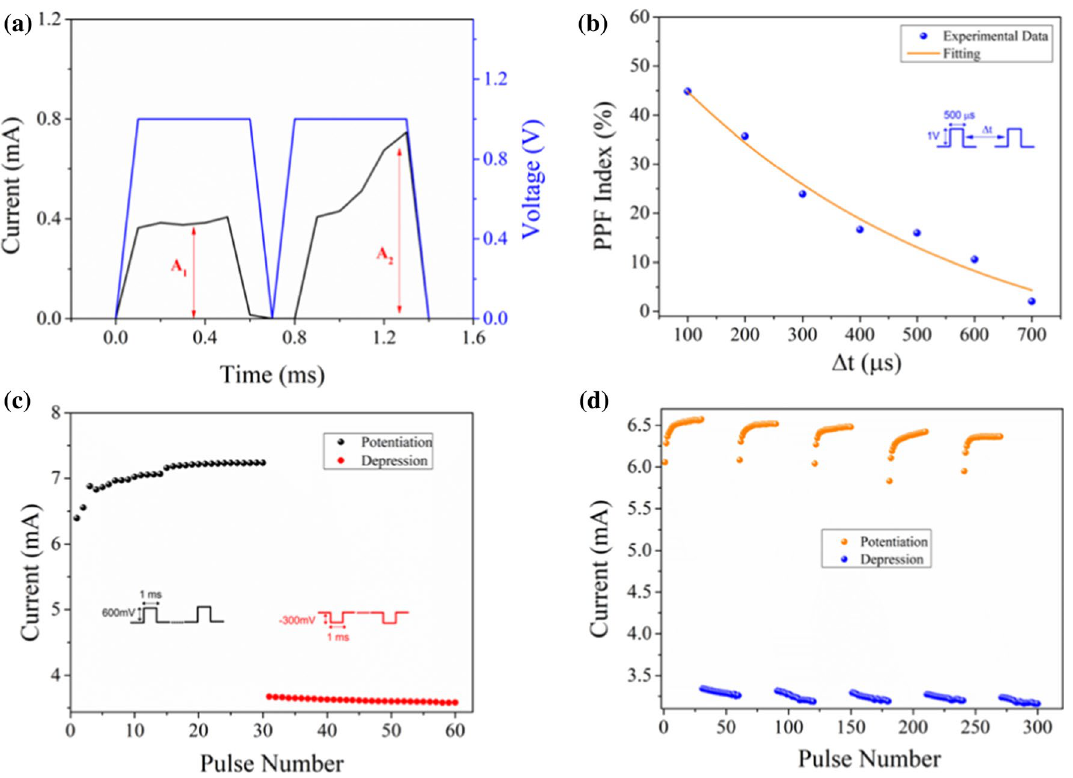
Fig. 3 ( a ) Illustration of PPF. ( b ) PPF as a function of Delay time, ( c ) single and ( d ) multiple LTP/LTD